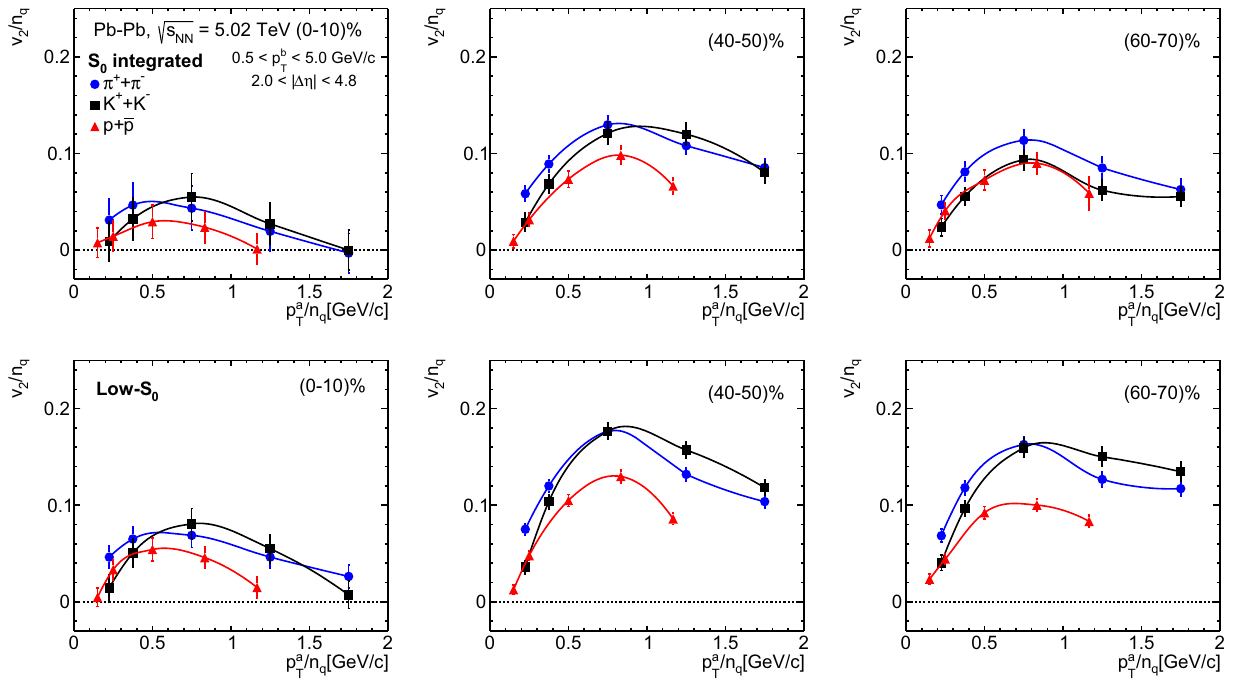
Fig. 6 Centrality dependence of elliptic flow co-efficient ( v 2 ( p a (red triangles) for spherocity-integrated (top panel) and low- S 0 (bottom panel) events in Pb + Pb collisions at model